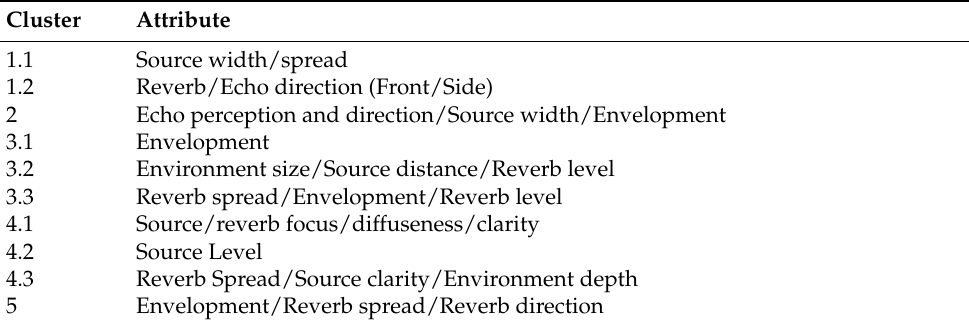
Table 2. In-Situ main construct categories based on